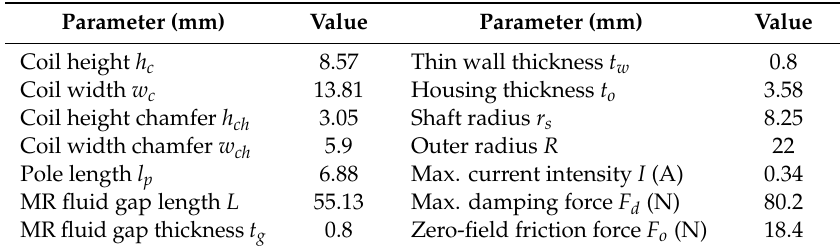
Table 3. Optimal parameters of the MR damping part.